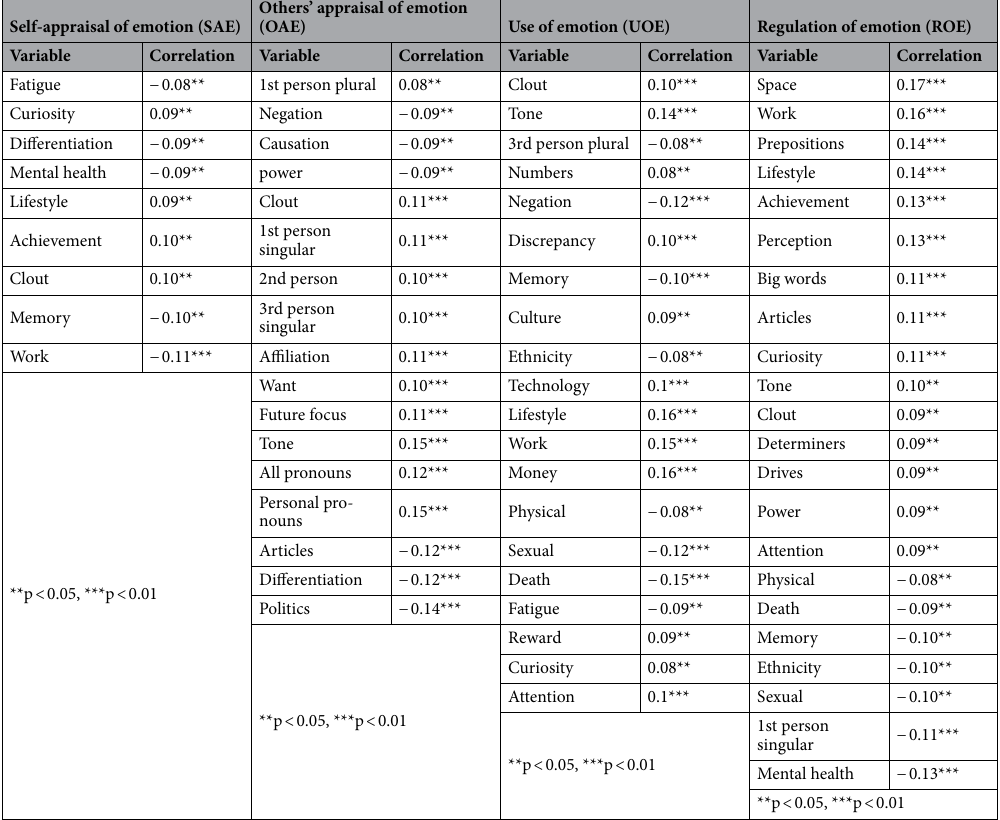
Table 4. Correlations between text variables that are not under the social and affect category and each of the four dimensions of EI. Only variables which exhibit correlations that are significant to the 5% percent level (p-values ≤ 0.05) are listed. Correlations between general category text variables and emotional intelligence.